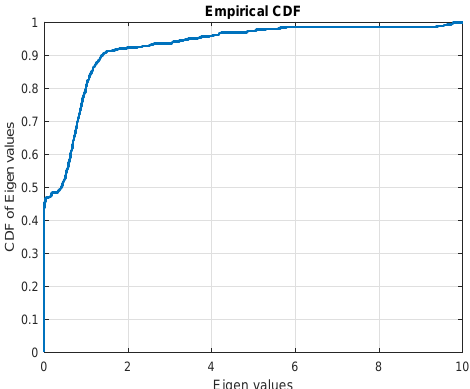
Figure 8. CDF of non-zero eigenvalues of channel covariance matrix R g for N t = 64.